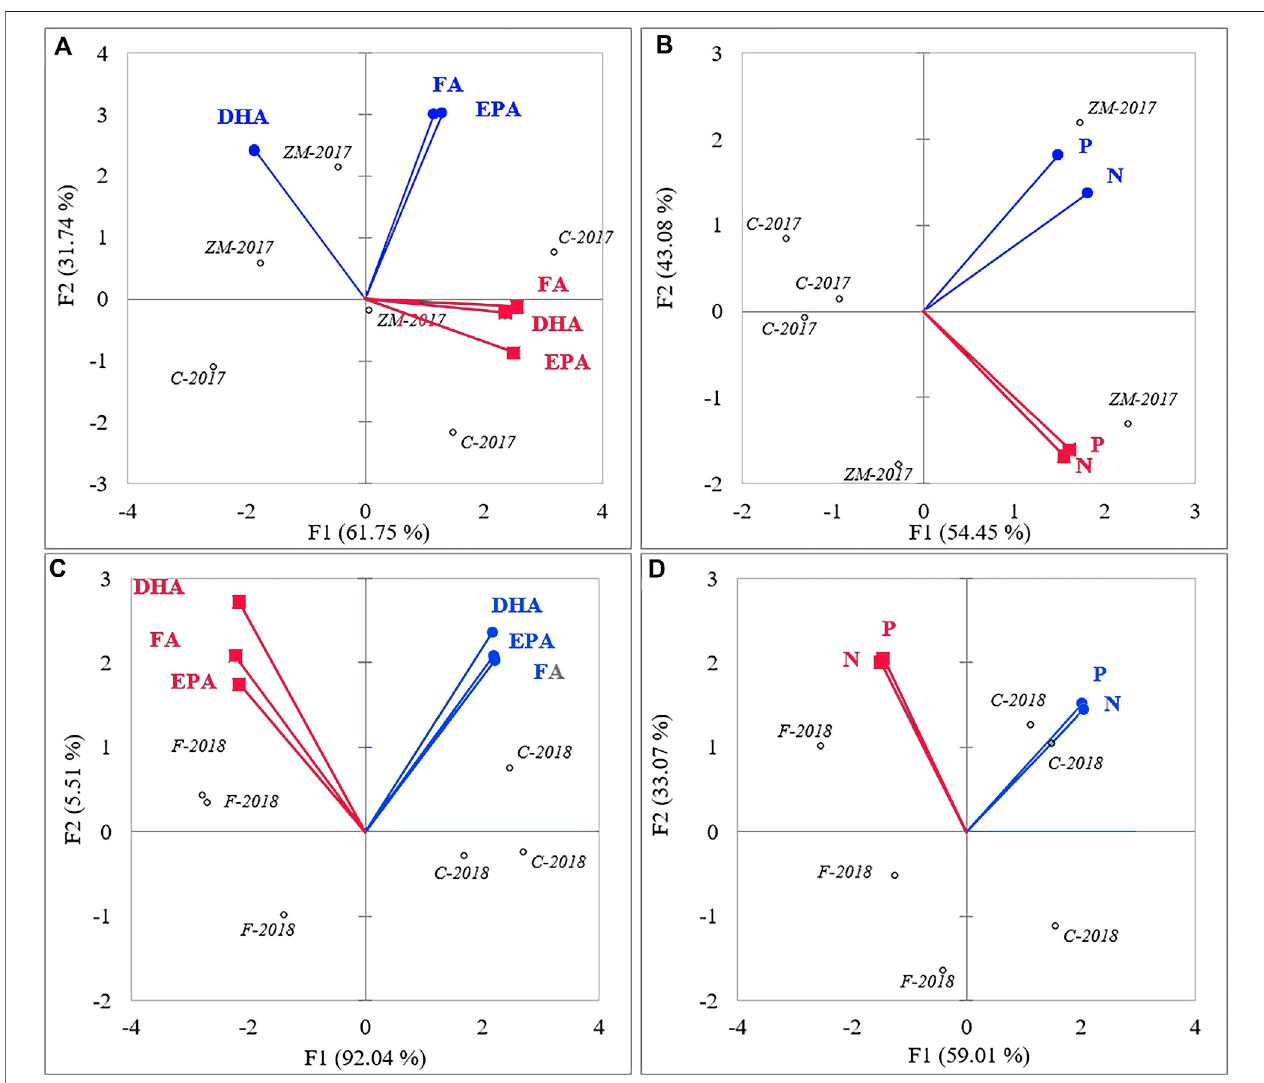
FIGURE 5 | Principle component analysis map ofproduction : biomass ratios of PUFAs (A, C) and nutrients (B, D) in phytoplankton (blue circles) and zooplankton (red squares) in the 2017 (A, B) and 2018 (C, D) treatments.